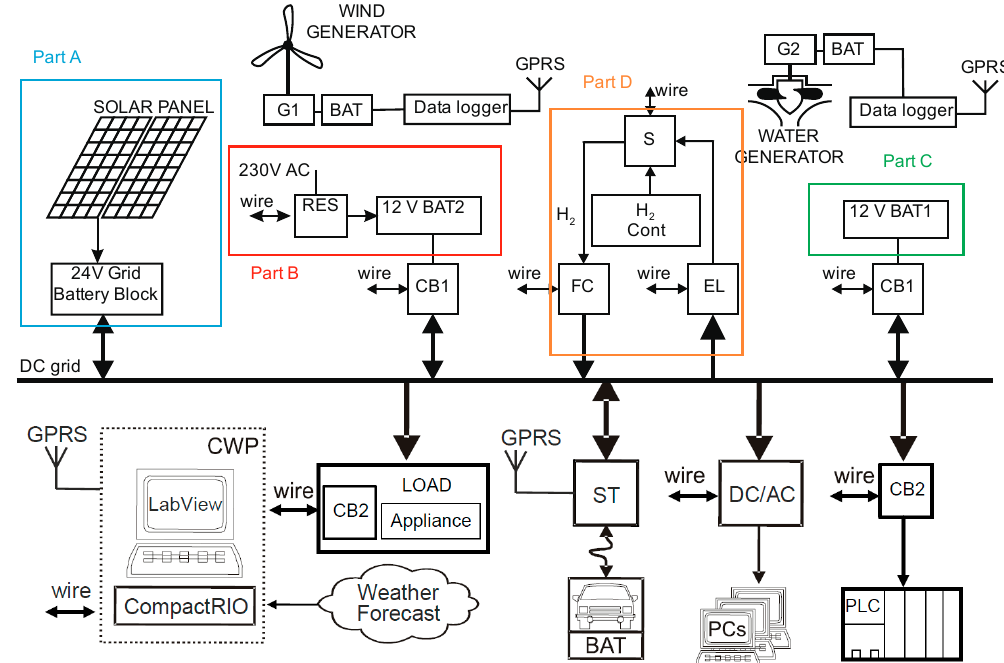
Figure 1. A block diagram of the smart energy model (SEM) (CB1—control block 1; CB2—control block 2; BAT (BAT1, BAT2)—battery; RES—physical model of a remote energy source; EL—electrolyzer; S—valve to switch and control the hydrogen flow to the fuel cell (FC); ST—vehicle charging station; G1—wind turbine generator, 12 V DC and 160 W; G2—water turbine generator with 230 V, 50 Hz, and 500 W; CC—control centre, CWP—central workplace.